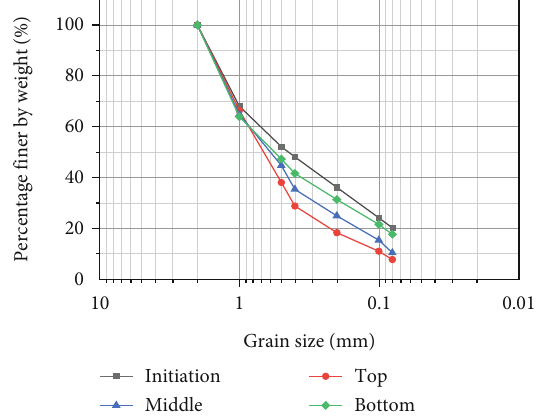
Figure 10: Test number 3 particle grading variation curves before and after seepage.